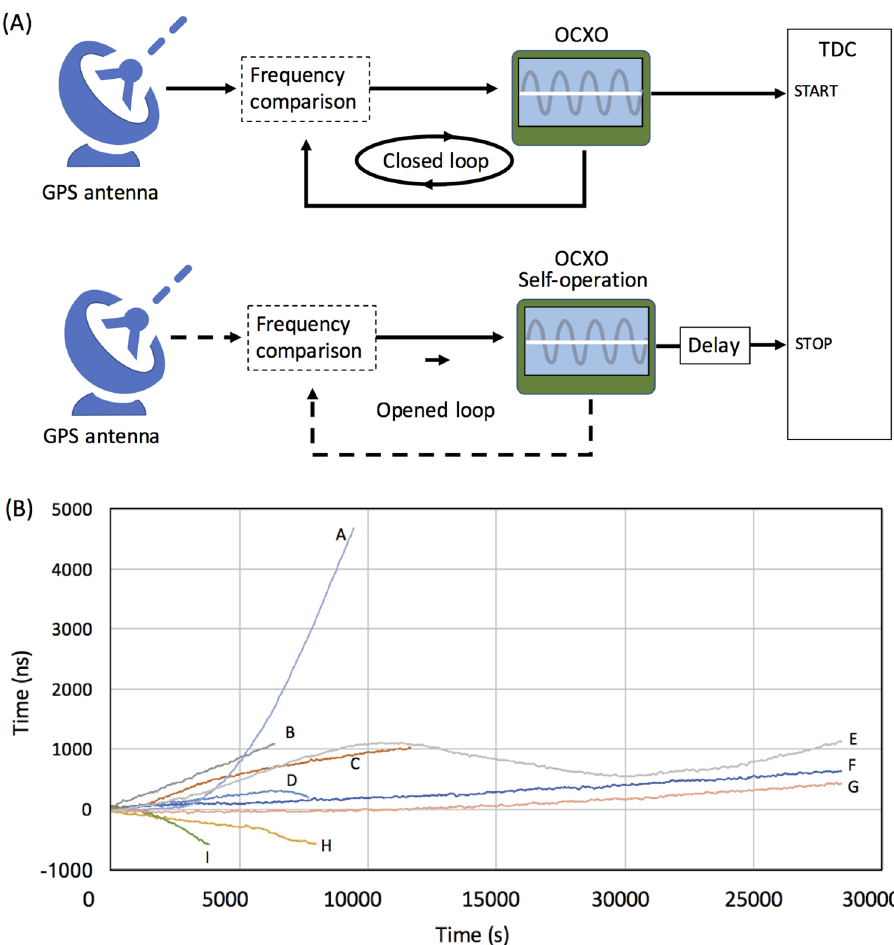
Figure 4. Results of the current OCXO evaluation. The block diagram of the current experimental setup is shown in ( A ). The dashed lines indicate the disconnected flows. The OCXO drift was measured as a function of the time after disconnection from the GPS antenna for various durations of the GPS reception before disconnection ( B ): A, 0.5 h, B, 48 h, C, 72 h, D, 16 h, E, 10 min, F, 0 h (no antenna connections), G, 8.5 h, H, 16 h, I, 1 h. HKMT drew this image and holds the